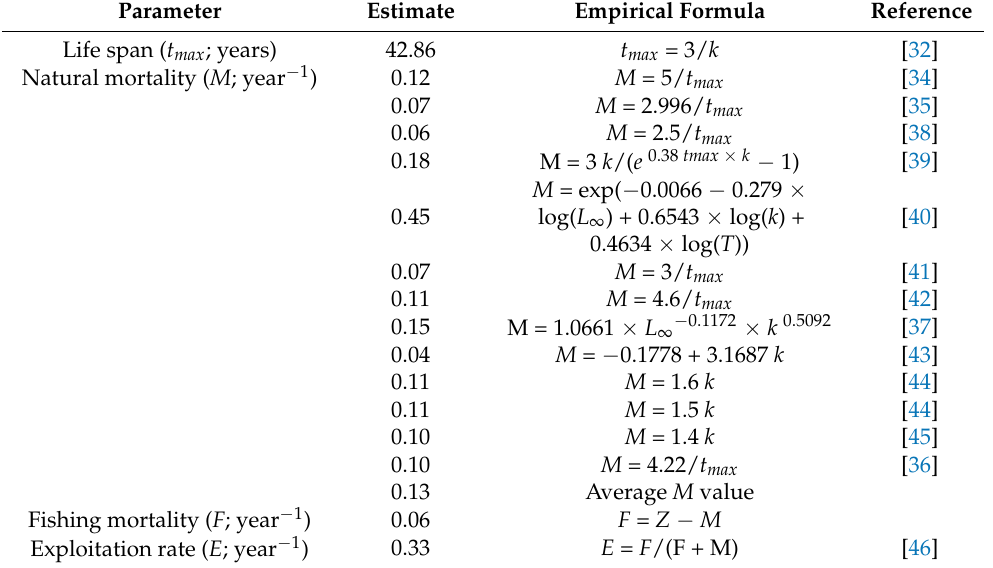
Figure 5. Estimates of total mortality rate ( Z ; mean ± 0.95 confidence interval) for Palinurus elephas in the Azores from the linearized length–converted catch curve method. Table 2. Natural mortality, fishing mortality and exploitation rate estimated for Palinurus elephas using empirical equations based on the approximate maximum age ( t max ); asymptotic length ( L ∞ ); and growth coefficient ( k ). M : natural mortality; T : mean annual water temperature of the region ( T = 18 °C; [19,48,49]). The L ∞ and k were derived from the CL-frequency data collected for the period 2000–01 in the Azores.